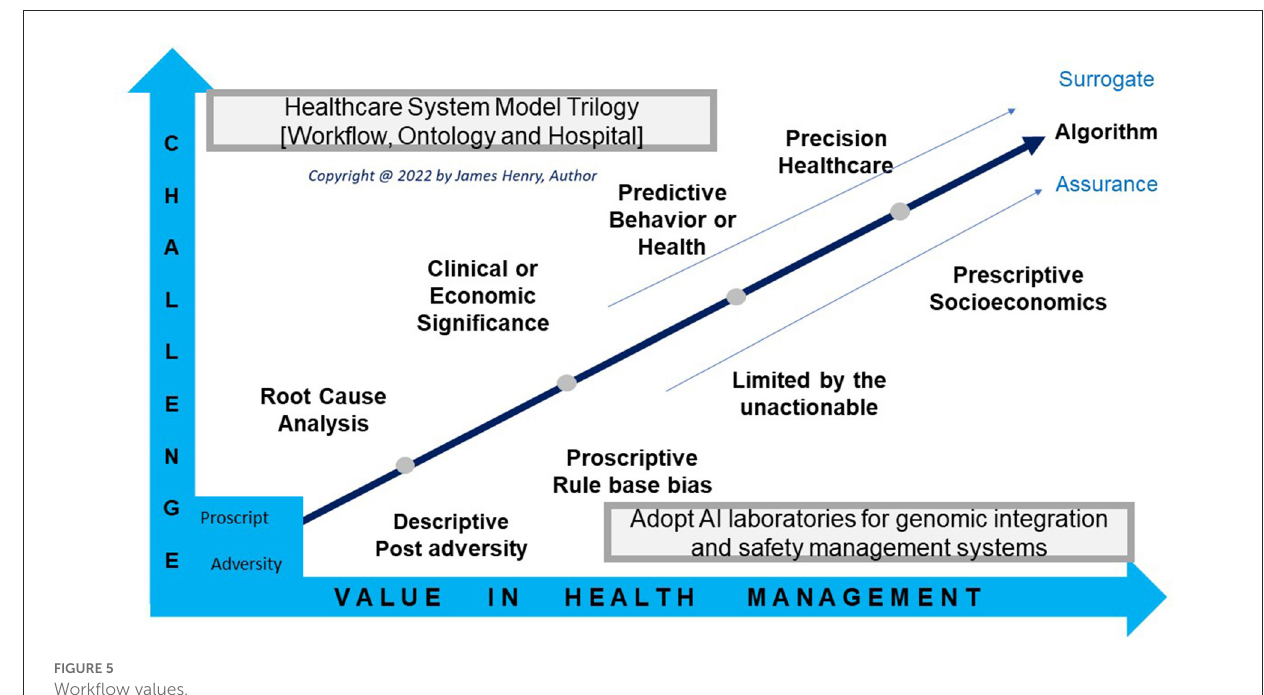
FIGURE5 Workflow